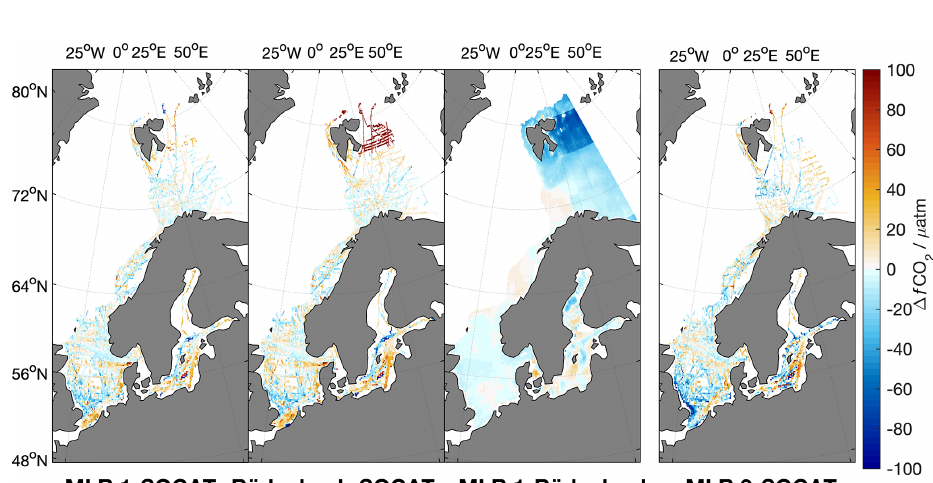
Figure 3. Average regional differences between MLR 1 and gridded SOCAT v5 data, the Rödenbeck map and gridded SOCAT v5 data, MLR 1 and the Rödenbeck map, and MLR 3 and the gridded SOCAT v5 data (from left to